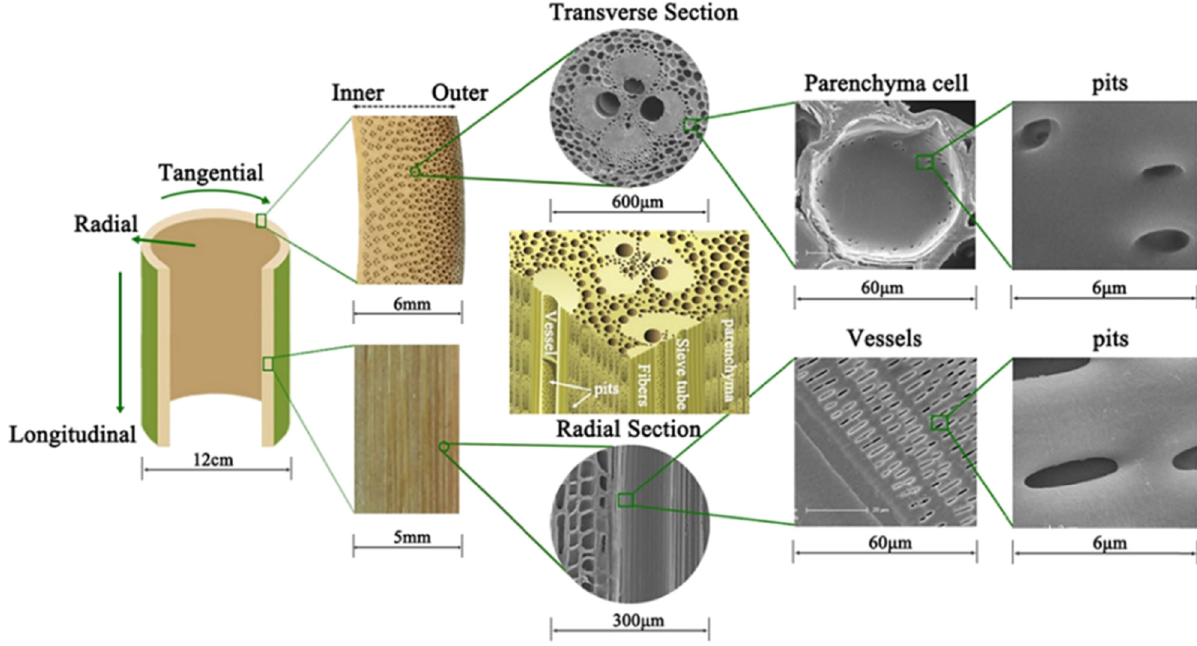
Figure 1: Schematics of the heterogeneous structure of bamboo [ 68 ]